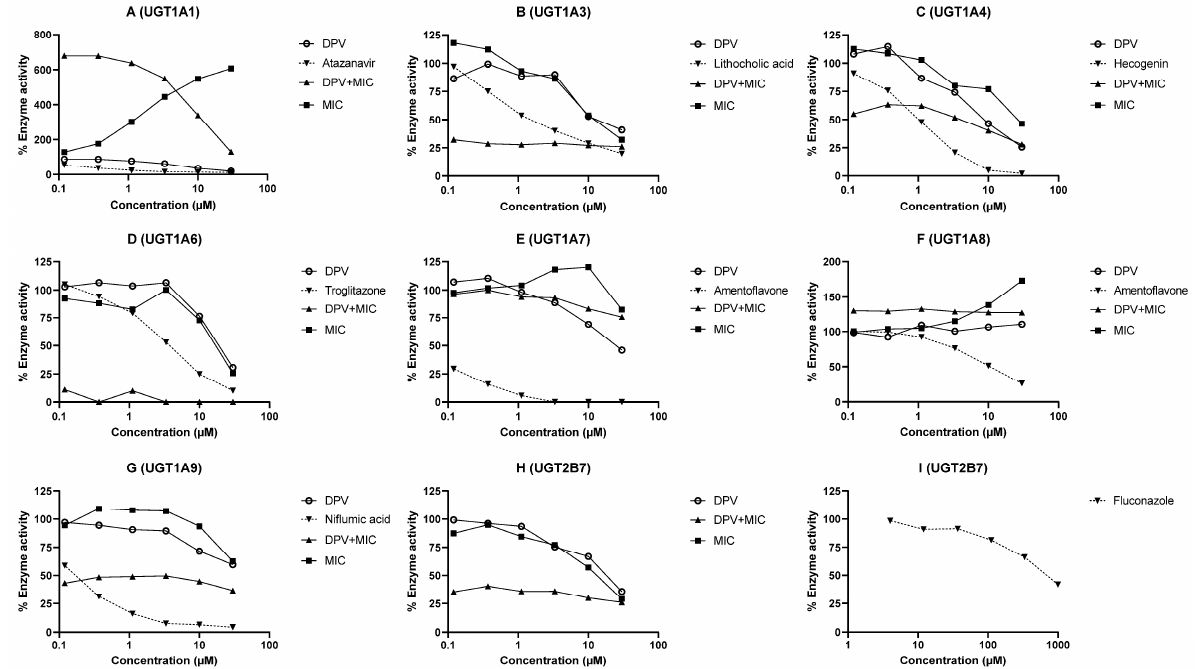
Figure 3. The UGT inhibition profiles of DPV, MIC and the combination of DPV and MIC determined using an individual probe substrate. Each test compound/inhibitor was incubated in a separate experiment using HLM or recombinant UGT with a substrate. Inhibition profiles of ( A ) UGT1A1 catalyzed SN38 glucuronidation, ( B ) UGT1A3 catalyzed chenodeoxycholic acid 24 O-glucuronidation, ( C ) UGT1A4 catalyzed trifluoperazine N-glucuronidation, ( D ) UGT1A6 catalyzed 4-methylumbelliferone O-glucuronidation, ( E ) UGT1A7 catalyzed 4-methylumbelliferone O-glucuronidation, ( F ) UGT1A8 catalyzed 4-methylumbelliferone O-glucuronidation, ( G ) UGT1A9 catalyzed mycophenolic acid glucuronidation, ( H ) and ( I ) UGT2B7 catalyzed zidovudine glucuronidation. The enzyme activity is expressed as % remaining activity compared with negative control (without inhibitor). Data are shown as the mean of two biological replicates.